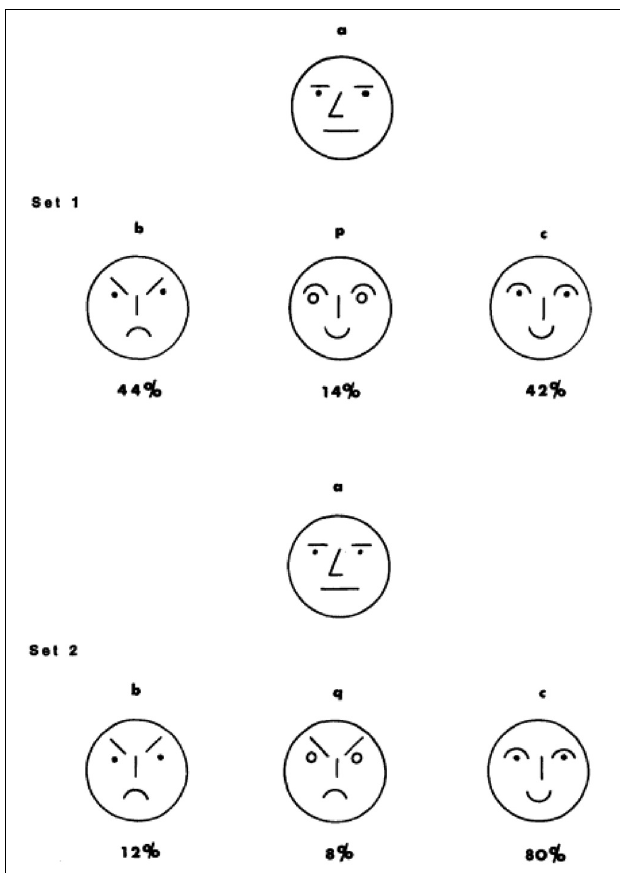
FIGURE 2 | Example of stimulus used in Experiment 4 (Tversky and Gati,